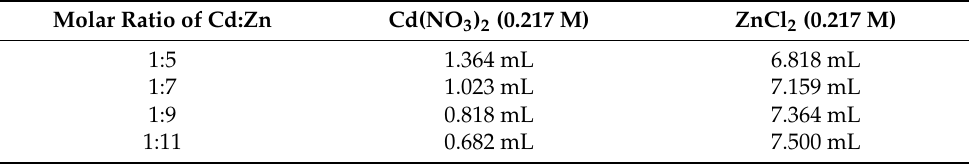
Table 3. Preparation of different molar ratios of Cd/Zn precursor solutions. Molar Ratio of